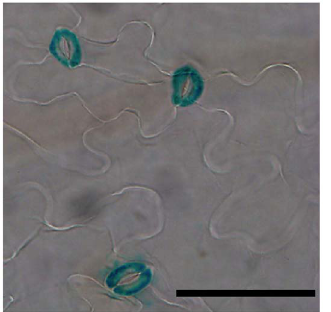
Figure 1. APK1b promoter direct GUS expression to the guard cells. GUS histochemical localisation of expression directed by the APK1b upstream gene promoter in leaves of 3 week old seedlings. Scale bar=50 m m.